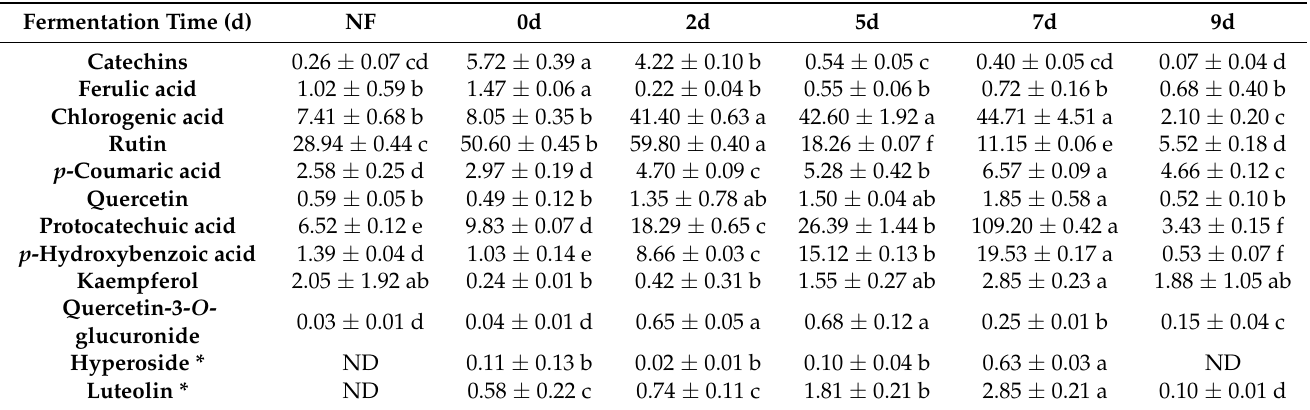
Table 1. Contents of the identified phenolic compounds in fermented Chinese jujube by M. purpureus